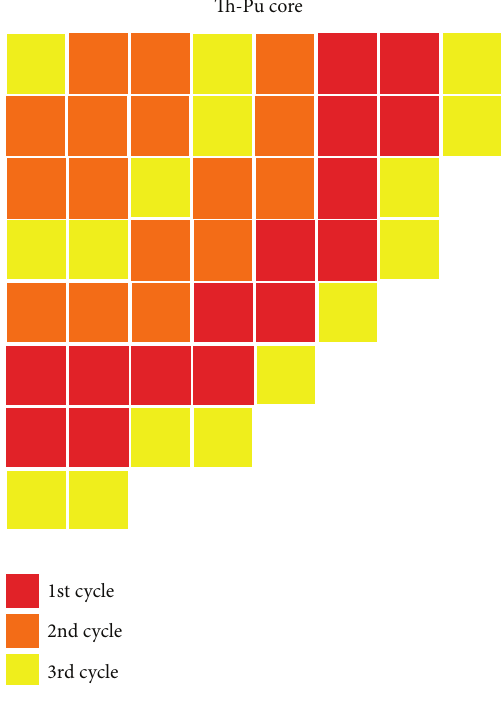
Figure 1: The UOX reference core. Figure 2: The Th-MOX